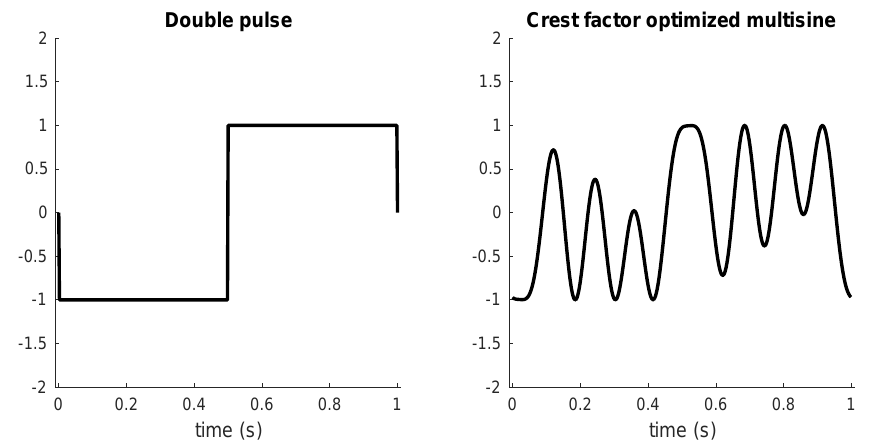
Figure 6. A double pulse (DP) input ( left ) and a crest factor optimized multisine (MS) input ( right